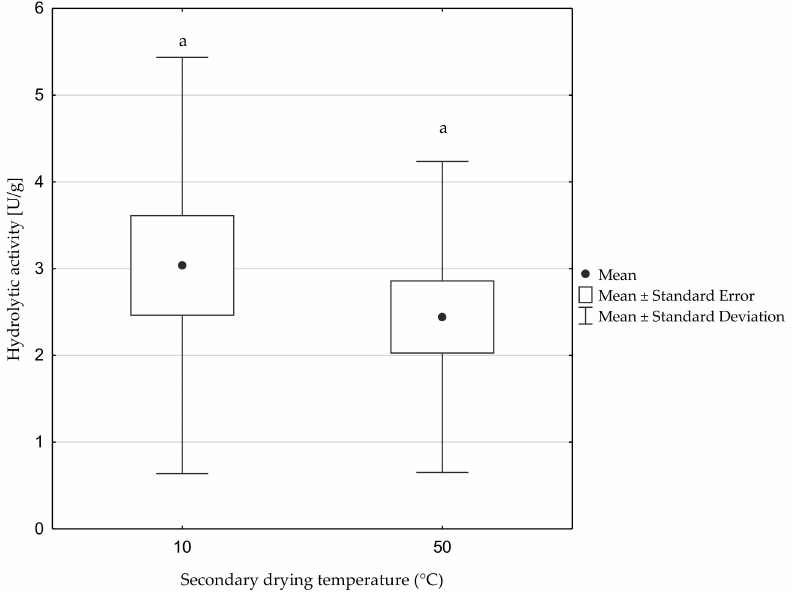
Figure 4. Effect of the secondary drying temperature on the hydrolytic activity of freeze-dried preparations. Significant differences are marked with letters of the alphabet. Experiments were performed in triplicate.